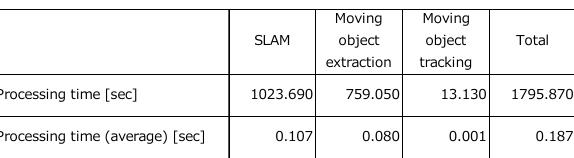
Table 2. Processing